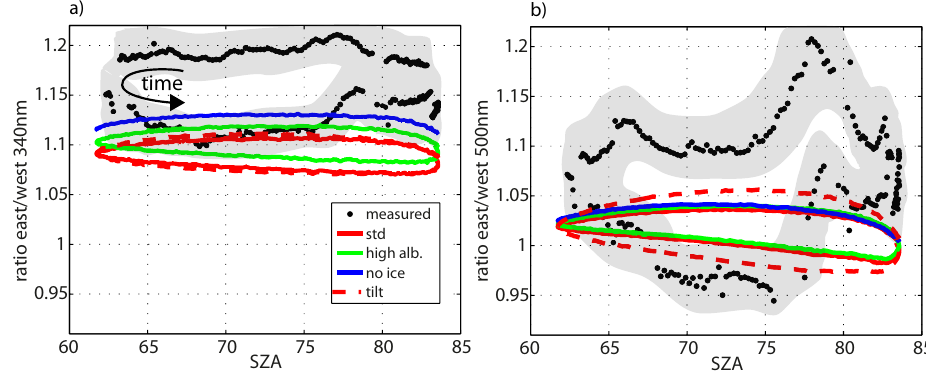
Figure 8. Ratios of global irradiances of stations east and west at wavelengths 340nm (a) and 500nm (b) plotted against SZA (black dots). The colored curves show the relevant model scenarios. The “no ice” scenario only applies to the morning. The legend refers to both plots (a) and (b) . The measurement uncertainties are illustrated by gray shaded areas. Time progresses in counterclockwise direction along the curves that exhibit an interesting